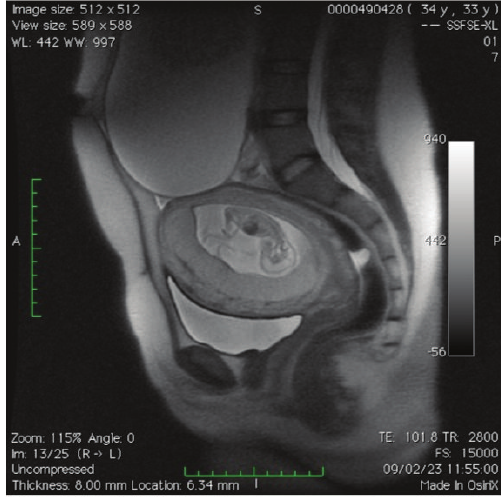
Figure2:MRIdemonstratingtherelationbetweentheadnexalmass and the pregnant uterus.